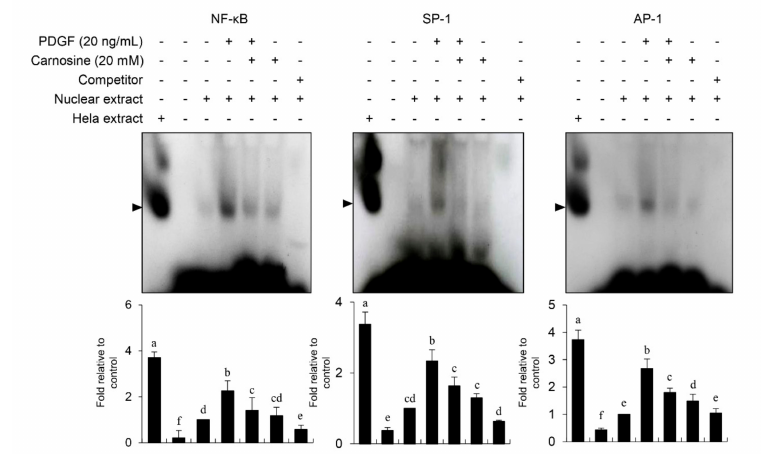
Figure 9. Carnosine disrupted MMP-9 activity by reducing the binding activities of Sp-1, AP-1, and NF- κ B motifs in PDGF-stimulated VSMCs. The nuclear extracts were collected and assayed for the binding activities of Sp-1, AP-1, and NF- κ B using EMSA with radiolabeled oligonucleotide probes. The quantified data from representative blots and plots are indicated. All data are expressed as the mean ± SE values of three experiments. The di ff erent letters indicate significant di ff erences between the groups ( p < 0.05).